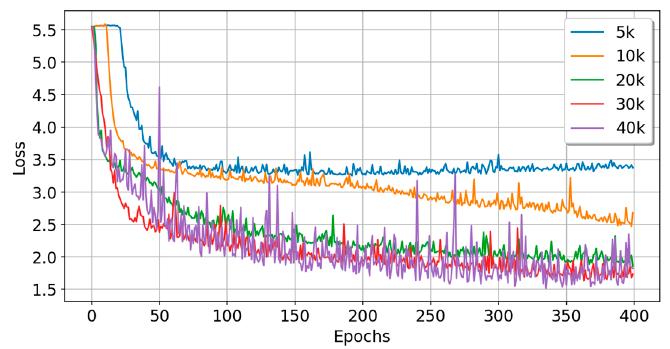
Figure 24. RNN loss values under different scales of data.